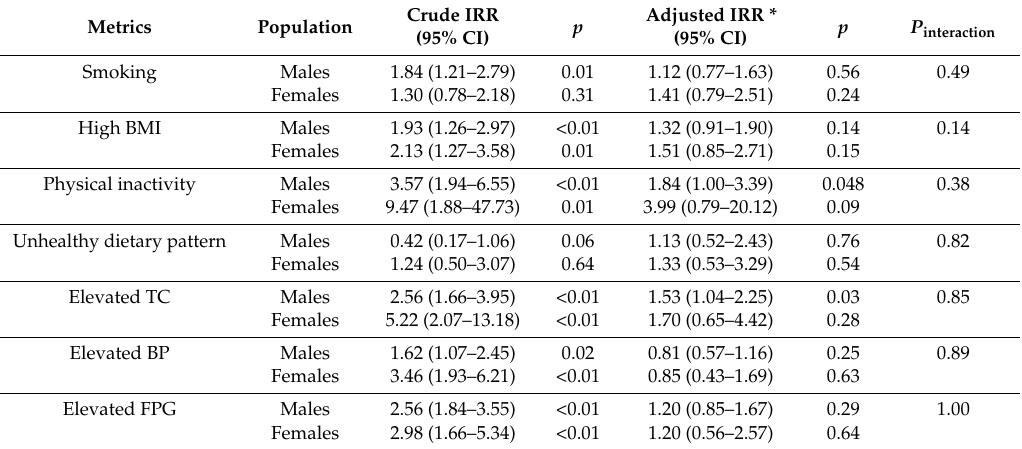
Table 2. IRRs between individual CVH metrics and IHD prevalence, stratified by sex.